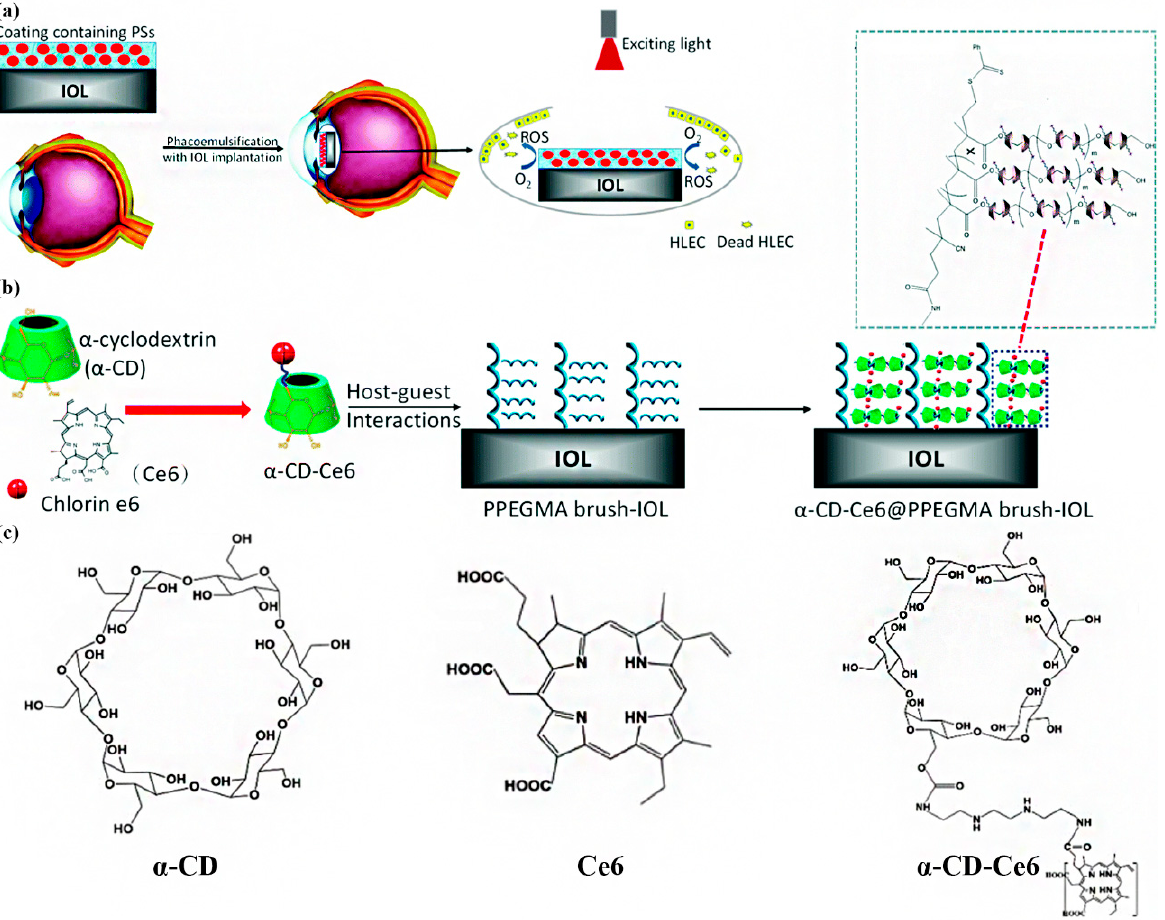
Figure 7. ( a ) Schematic illustration of an IOL with PS-containing coating and the process of PDT. ( b ) Schematic of the surface coating structure of the IOL. ( c ) Chemical structure of α -CD, Ce6, and α -CD-Ce6. Adapted with permission from Ref. [87]. Copyright 2021 Royal Society of Chemistry.